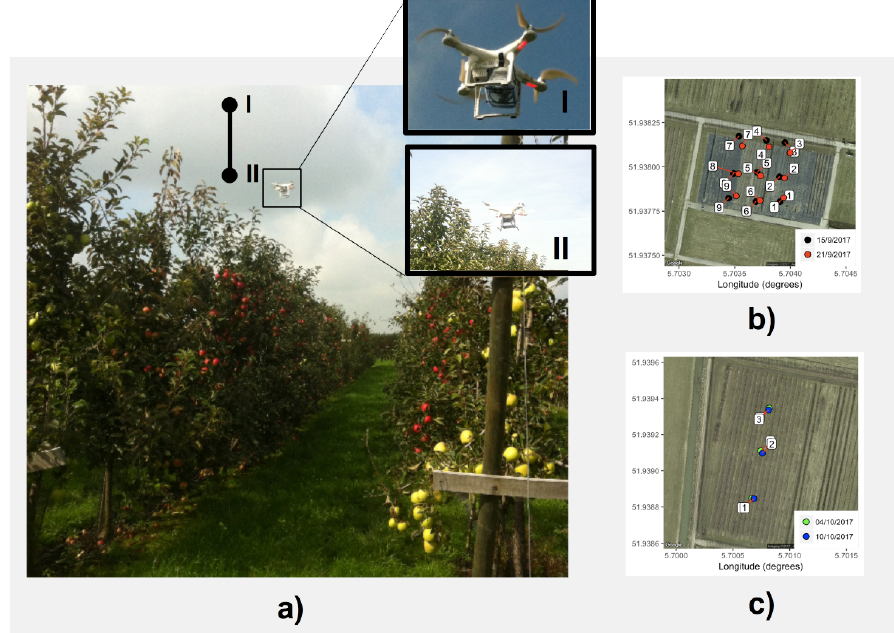
Figure 14. Hovering and sampling at two different position per experiment: ( a ) low and high heights within the orchard; ( b ) samples on Study Field A over the two days; and ( c ) samples on Study Field B over the two